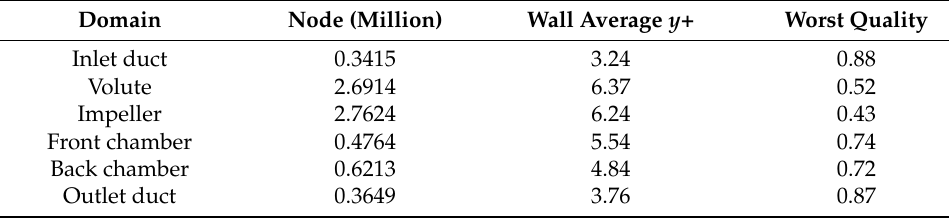
Table 3. Mesh information of each